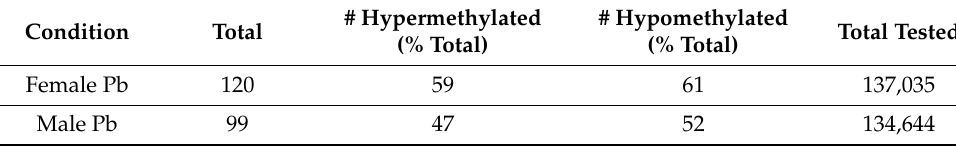
Table 2. Numbers of differentially methylated regions (DMRs) in weanling mouse